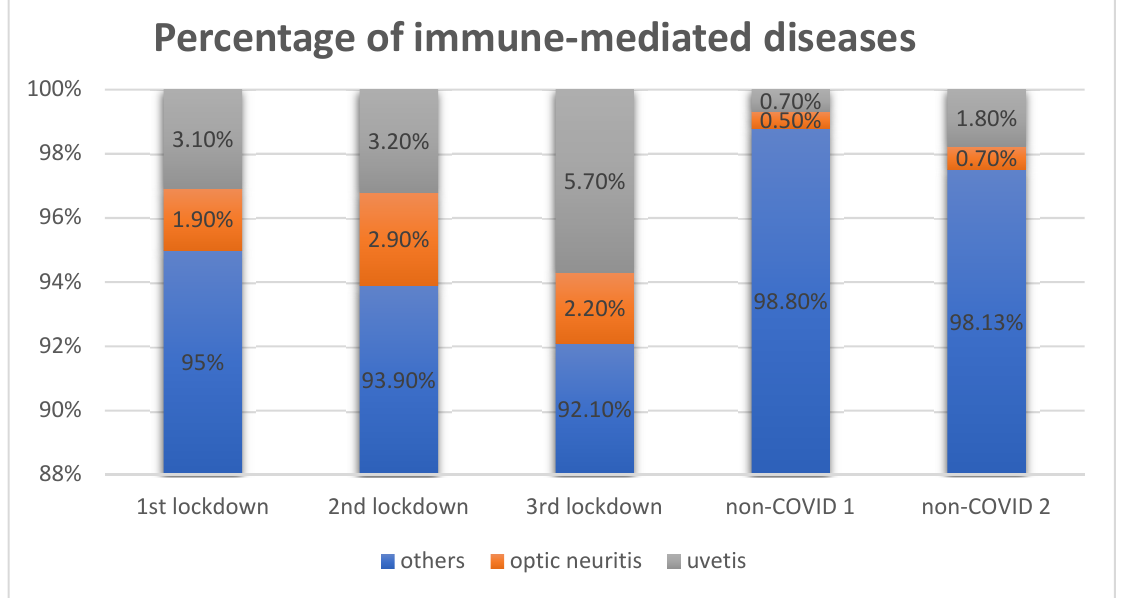
Figure 1. Proportion of immune-mediated diseases in the Emergency Eye Department, the Medical University of Warsaw in three lockdowns (1st lockdown = 16th of March to 15th of April 2020, 2nd lockdown = 1st to 30th November 2020, 3rd lockdown = 16th of March to 15th of April 2021 and corresponding time in 2019 (non-COVID 1 = 16th of March to 15th of April 2019, non-COVID 2 = 1st to 30th November 2019).